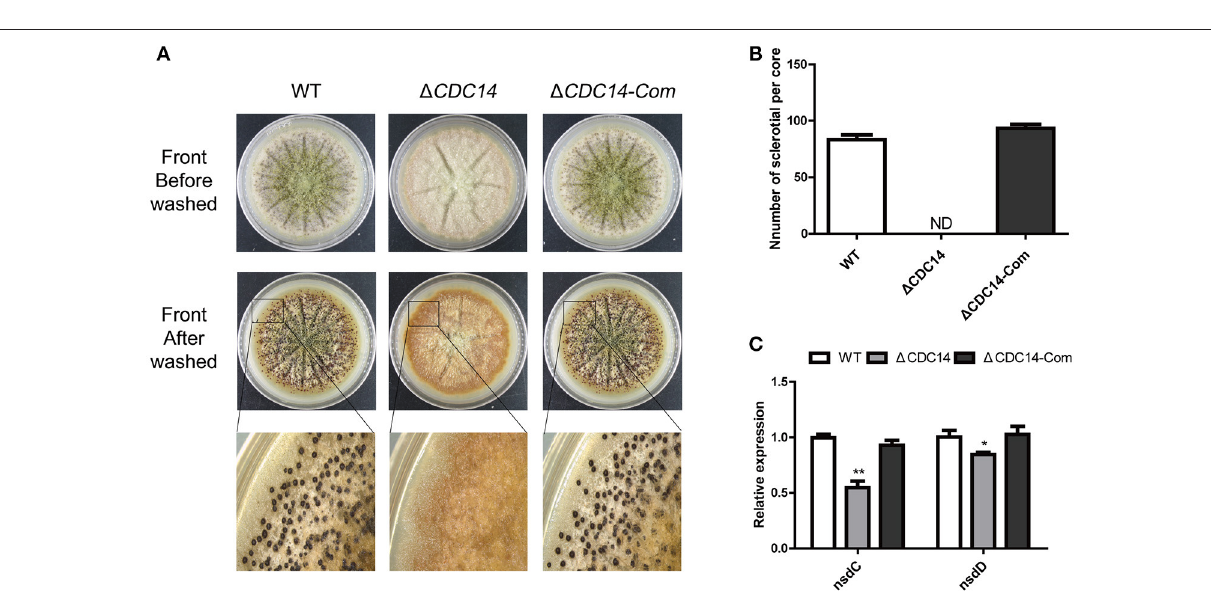
FIGURE 5 | AflCDC14 was essential for sclerotial formation. (A) Phenotypic characterization of WT, 1 CDC14 and 1 CDC14- Com strains on Wickerham medium at 37 ◦ C for 7 days. (B) Sclerotial amounts produced by A. flavus strains. ND means not be defined. (C) Expression levels of sclerotial related genes nsdC and nsdD in different strains for 48h (* p ≤ 0.05, ** p ≤